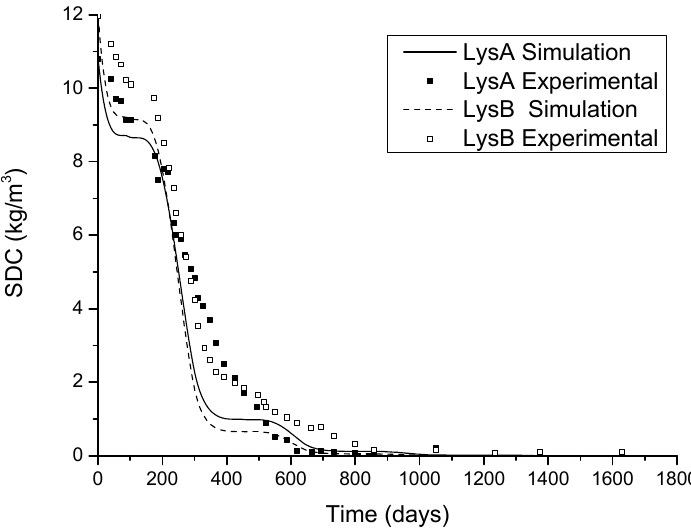
Figure 7. Time profiles of SDC degradation (experimental data cited in [37]).